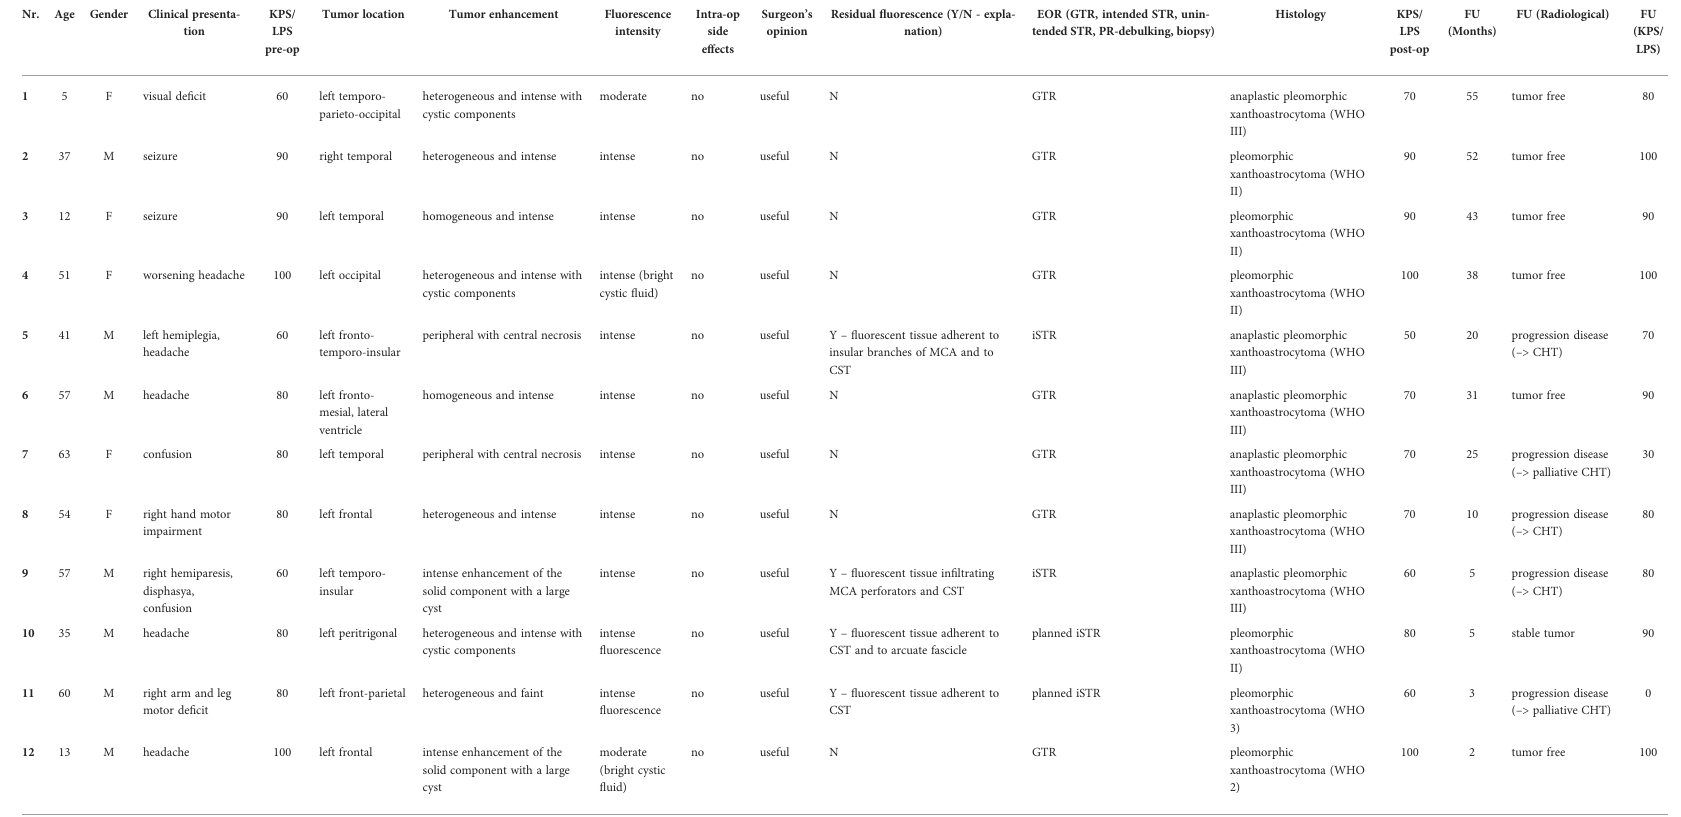
TABLE 1 Characteristics of the patients and main results. Nr. Age Gender Clinical presenta-